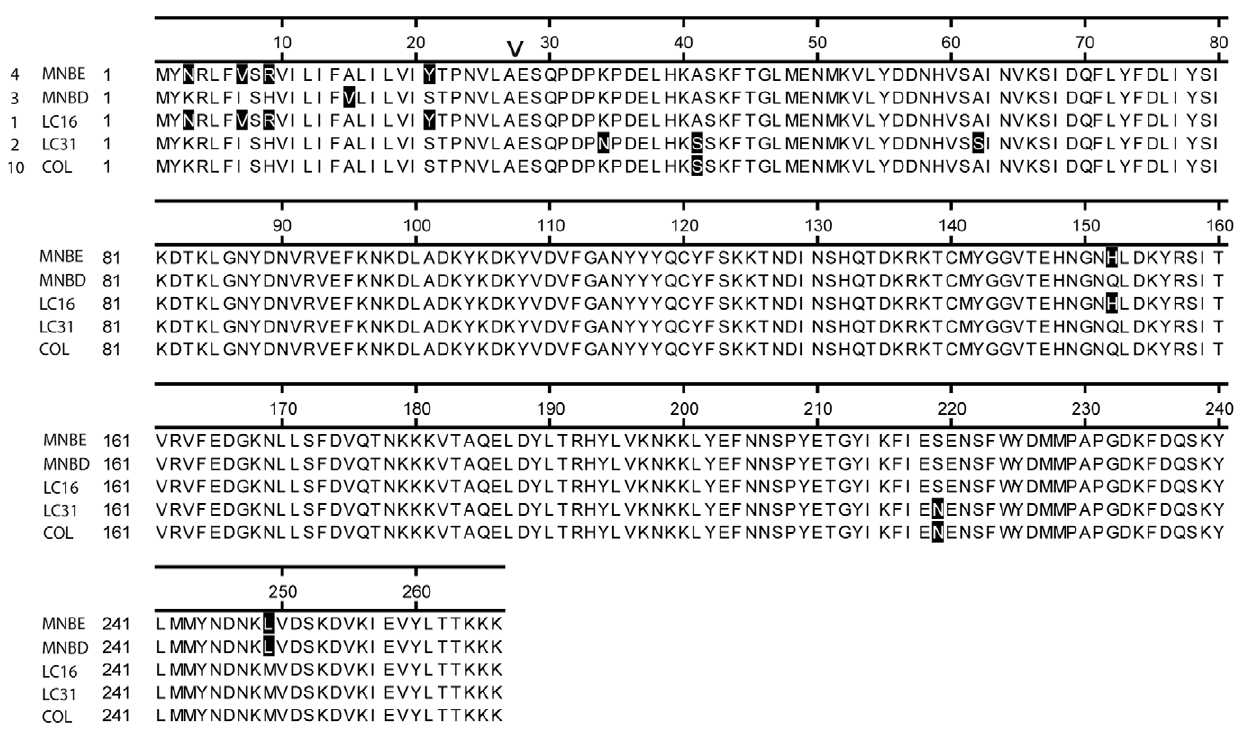
Figure 1. Alignment of the signal peptide and mature protein amino acid sequences of variant forms of SEB. The predicted, translated signal peptide and mature protein amino acid sequences of five variants of SEB were aligned by Clustal W. Varying amino acids are in red. Strain sequences listed are from MNBE, MNBD, LC16, LC31, and COL; the SEB sequences for strains MNHO and COL are identical. The numbers in front of strain names list the number of strains having that sequence. Numbers above the sequences indicate amino acid numbering including the signal peptide. Carat indicates the signal peptide cleavage site.